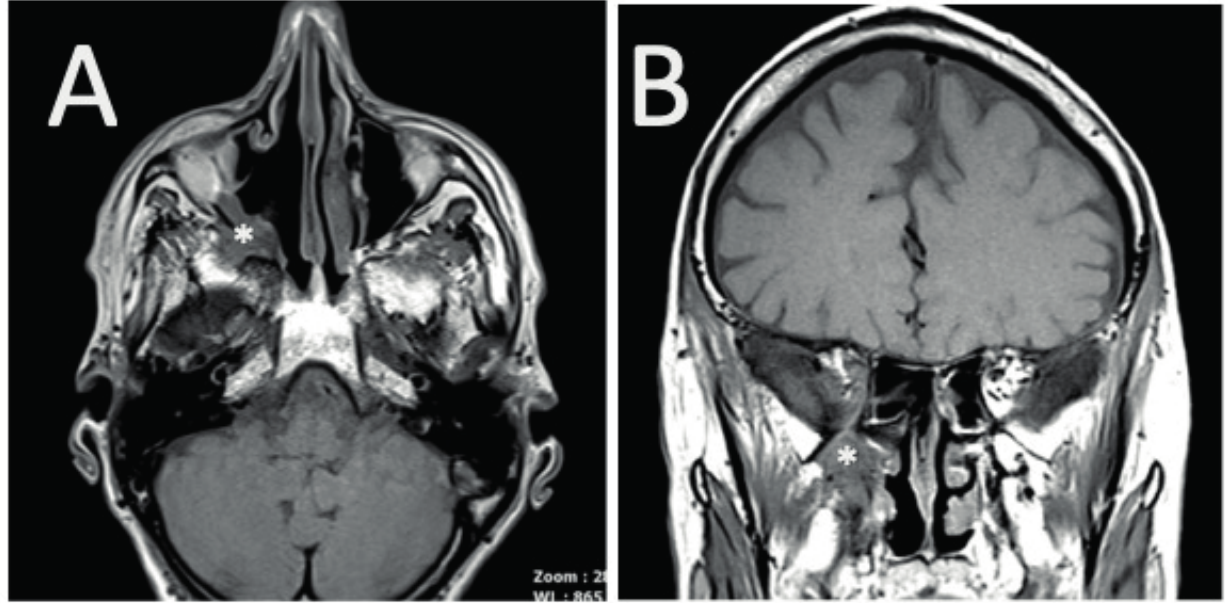
Figure 1. A. T1 W axial MRI showing hypointense lesion (*) in the right pterygopalatine fossa involving the right orbital apex. B. T1 W coronal MRI showing a hypointense lesion suggesting a combination of fibrosis and attenuated cellularity. These lesions may show marked Gadolinium enhance-